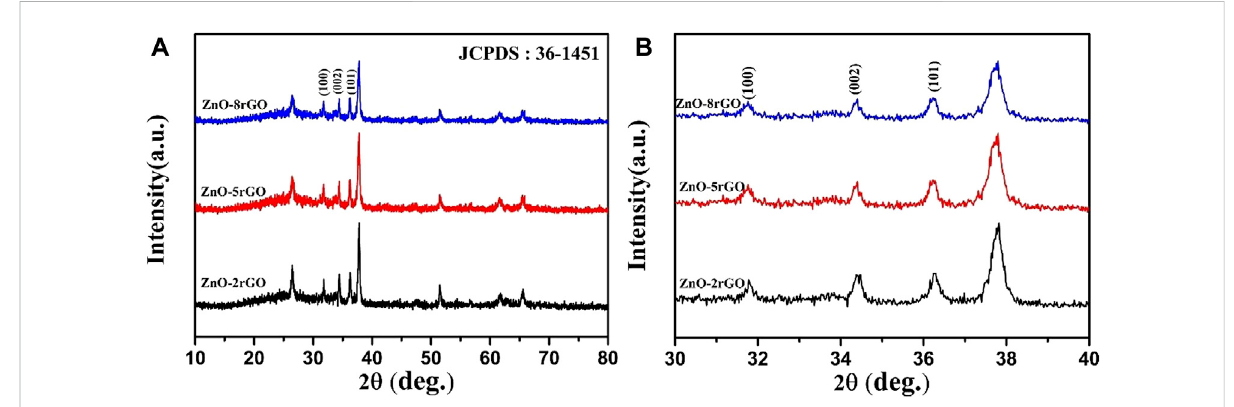
FIGURE 8 XRD spectra of ZnO-rGO composite prepared with different GO concentration (A) and partially enlarged pattern (B) .